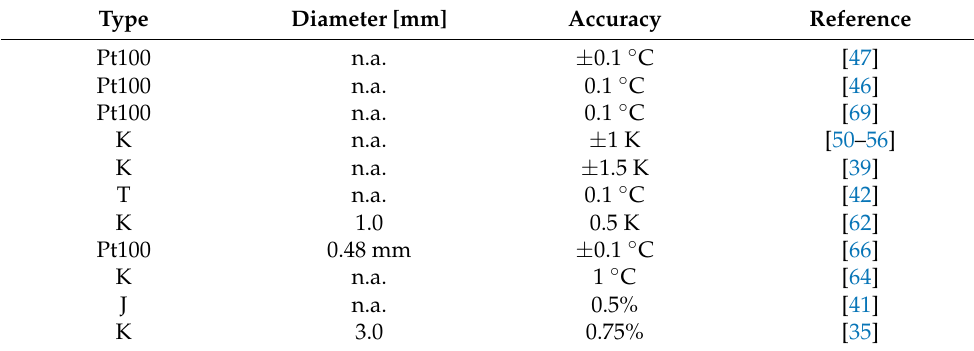
Table 17. Sensors for temperature measurement are used in experimental rigs with direct-contact condensers.